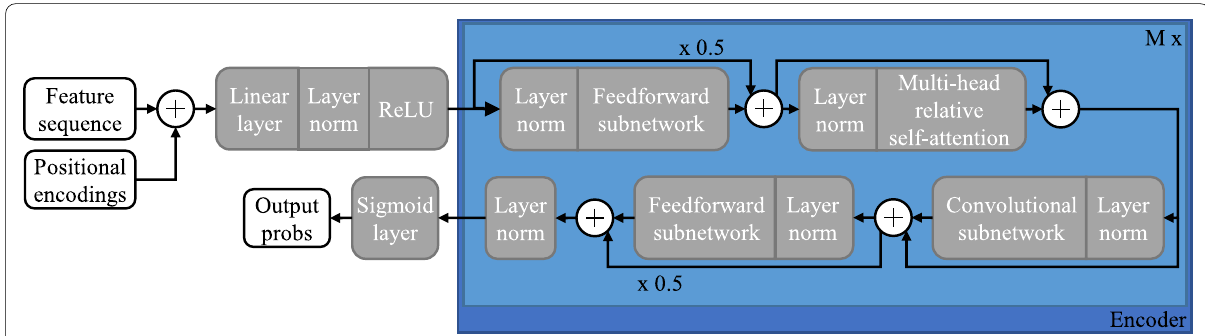
Fig. 2 Diagram of conformer encoder model for sound